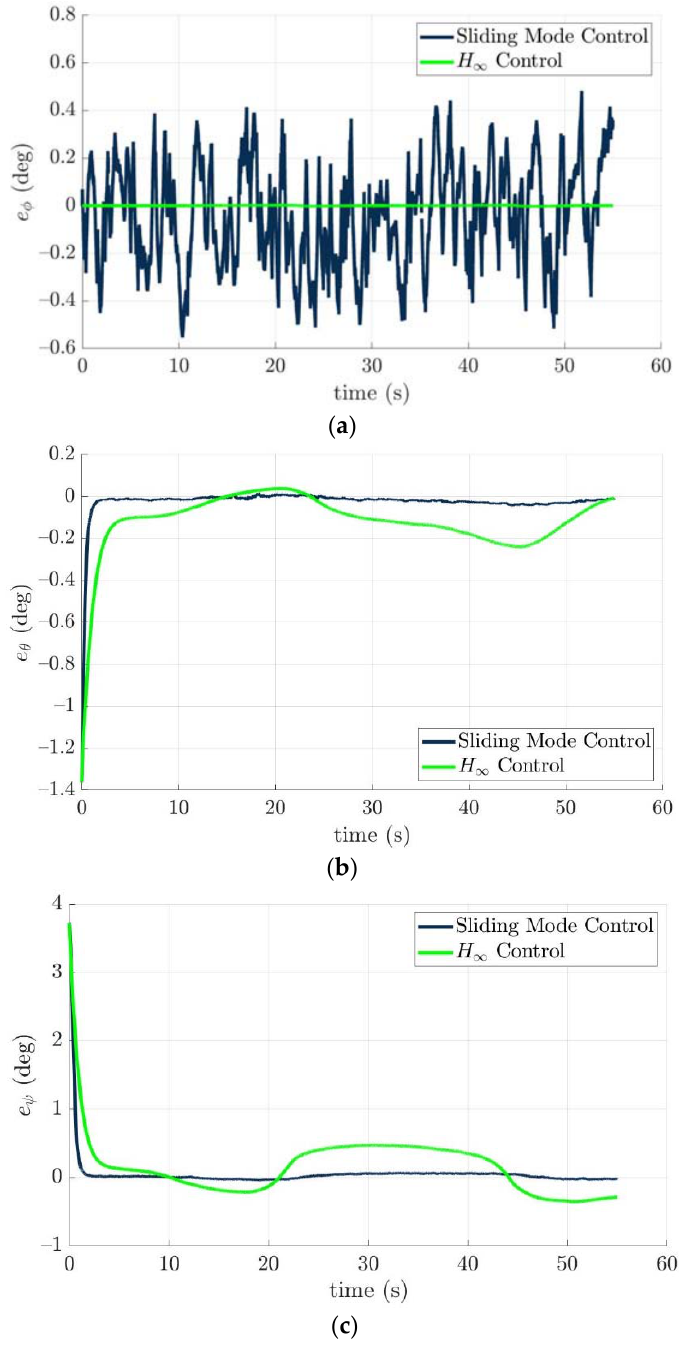
Figure 13. Histories of the attitude tracking errors of the torpedo-like underwater vehicle: ( a ) roll direction, ( b ) pitch direction, and ( c ) yaw direction.